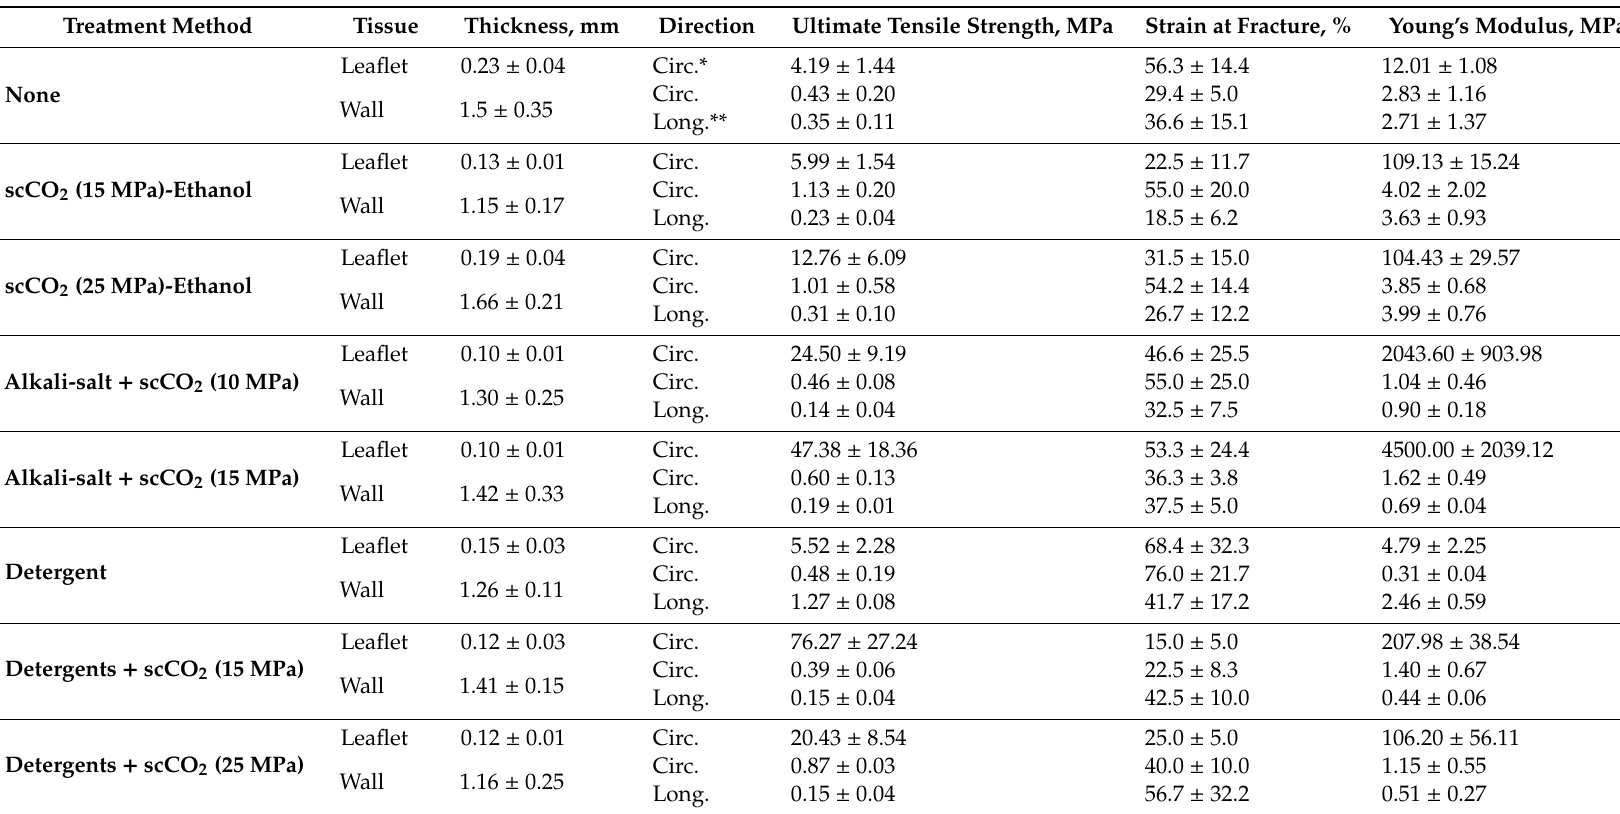
Table 1. Thickness and mechanical properties of native and decellularized ovine aortic valve leaflets and walls measured from stress-strain curves obtained via uniaxial tensile